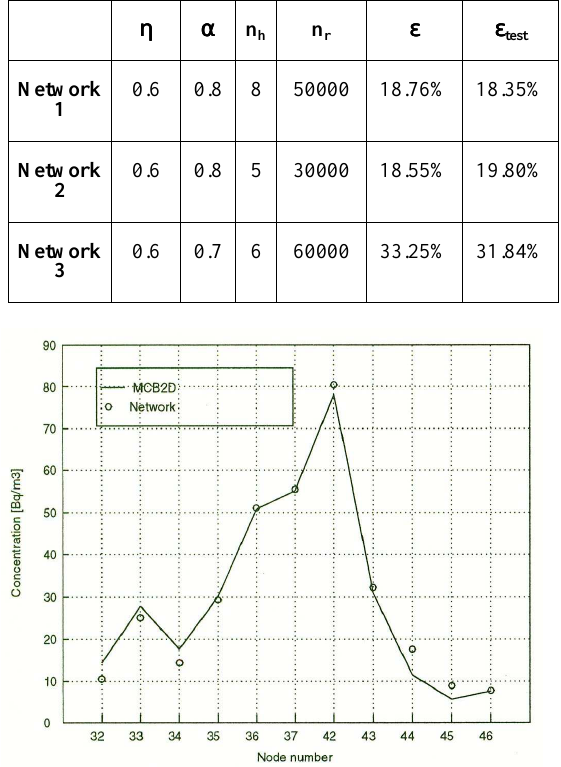
Table 4.2. Networks parameters and performances.